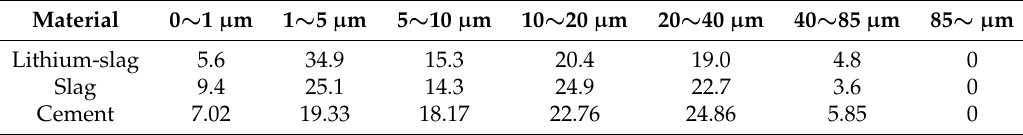
Table 3. The particle size distribution of slag, lithium-slag, and cement (%).